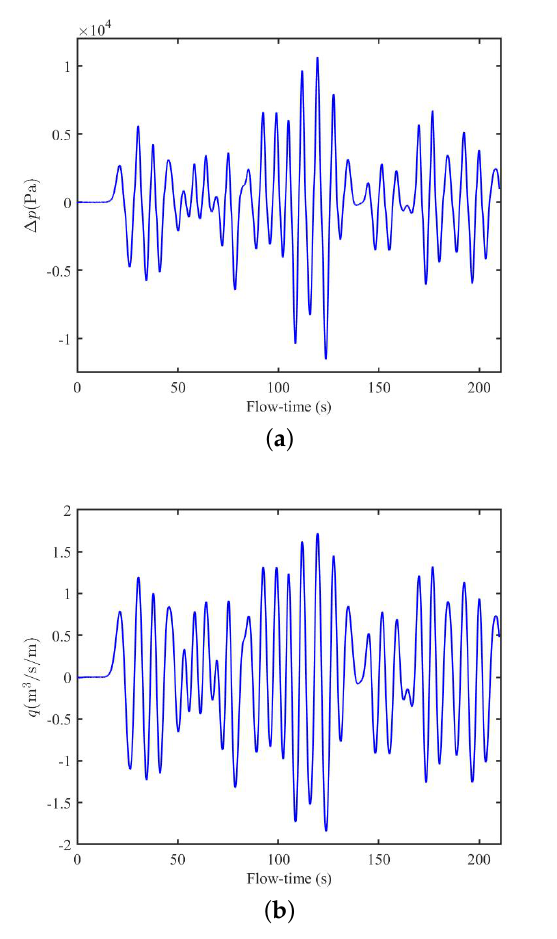
Figure 17. Variation in the ( a ) pressure drop, and ( b ) flow rate vs. the flow-time, with H s = 1.18 m and ω p = 0.967 Hz.